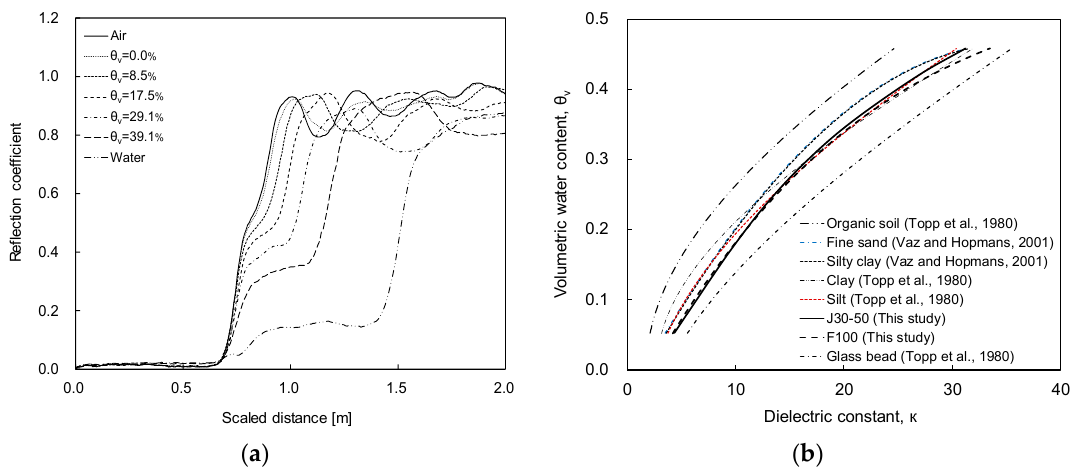
Figure 5. TDR calibration: ( a ) TDR waveform for J30-50 sand; ( b ) relationship between the dielectric constant and the volumetric water content. θ v denotes the volumetric water content.